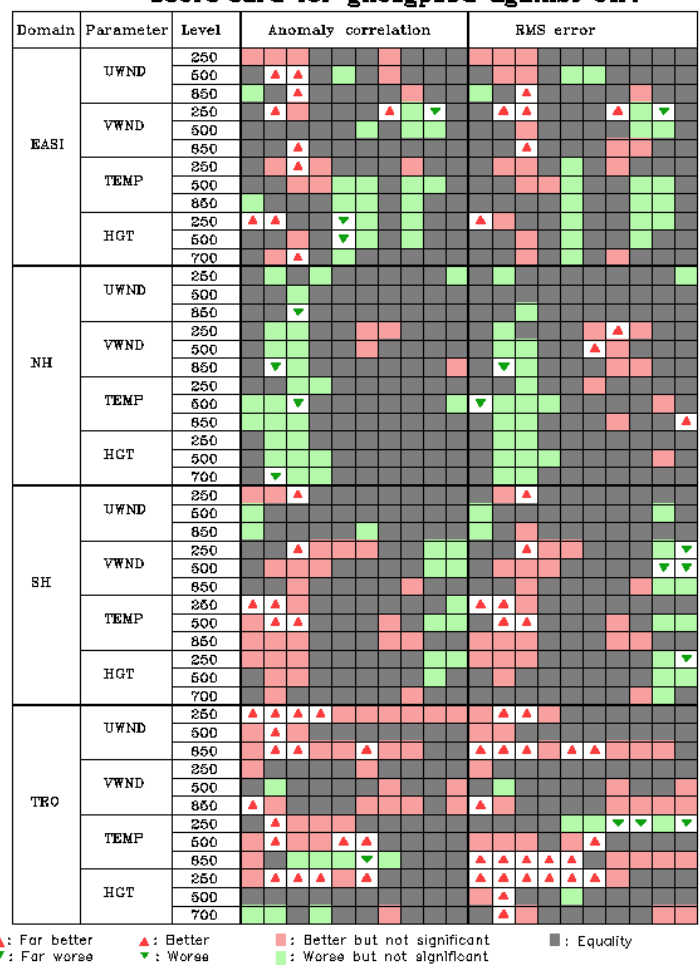
Figure 10. Evaluation score card of GPS and BDS FY-3C GNOS RO data assimilation effects on the GRAPES forecast